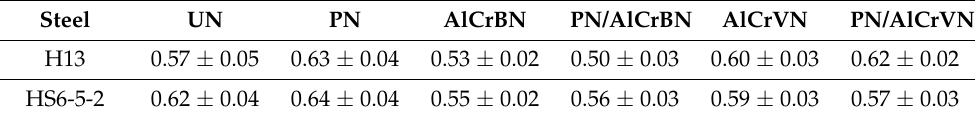
Table 7. Friction coefficient of tested